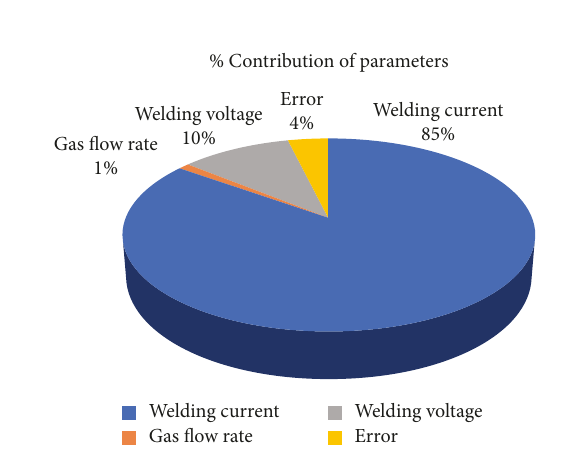
Figure 6: % contribution of parameters for